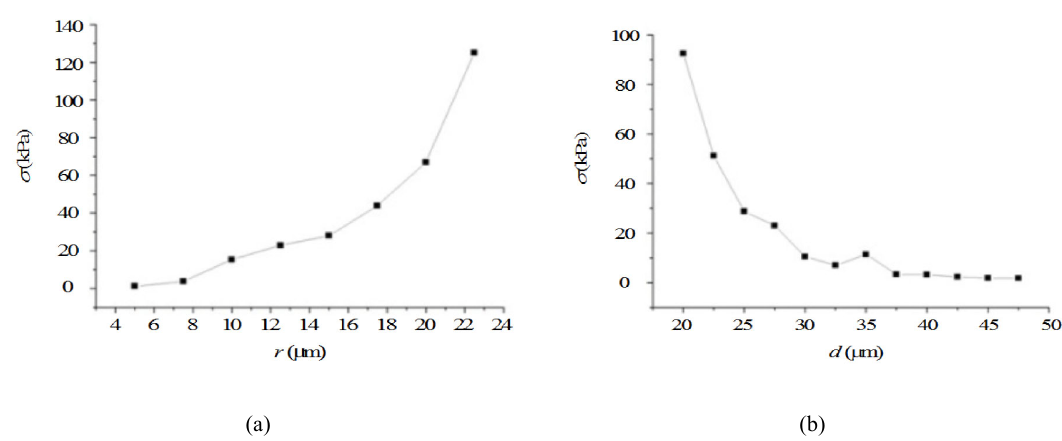
Fig. 8 Strain difference changes with (a) radius r and (b) distance d at the temperature of 80 ℃ .